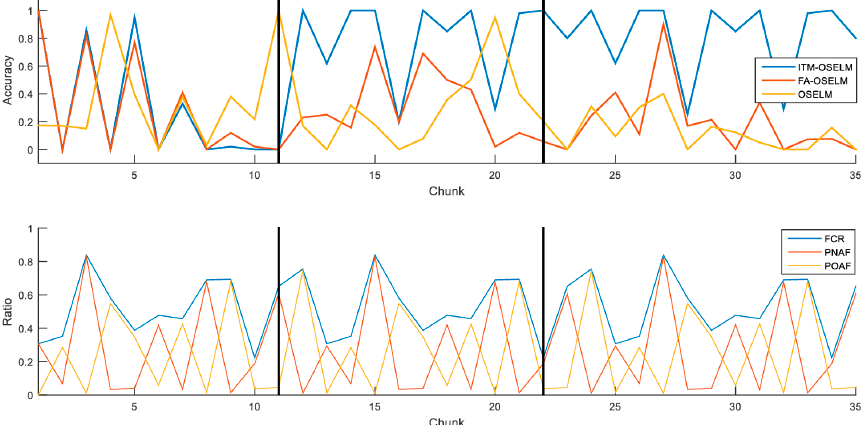
Figure 6. Accuracy change with respect to data chunks for three cycles using the TampereU dataset.